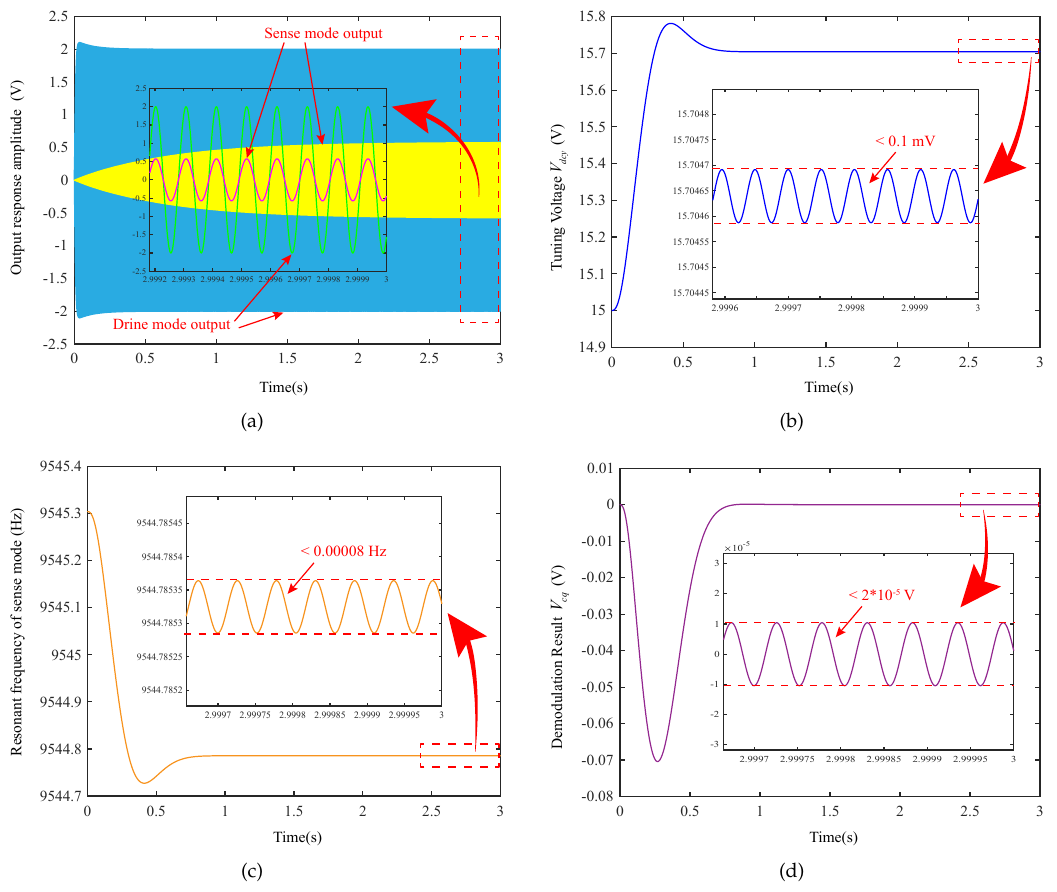
Figure 6. Automatic mode-matching process: ( a ) output response amplitudes ( V d and V s ) of two modes; ( b ) tuning voltage V dcy ; ( c ) demodulation Result V cq ; ( d ) resonant frequency of sense mode f yy ( f yy (cid:44) ω yy / ( 2 π )